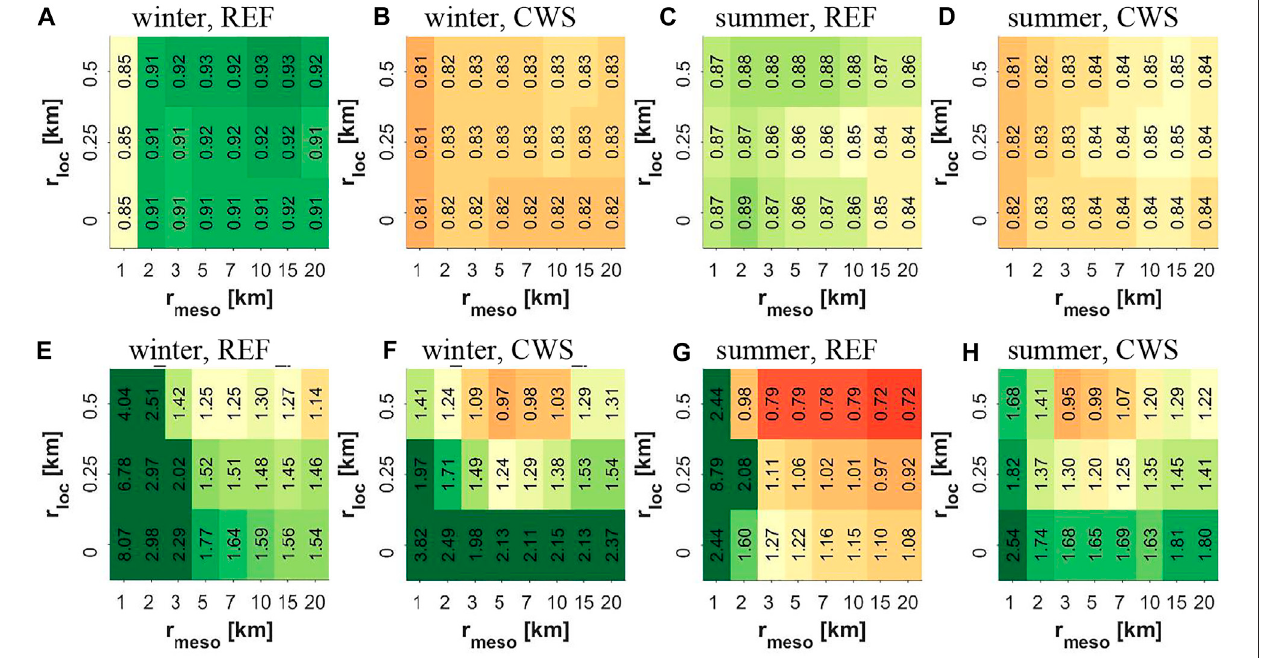
Frontiers in Environmental Science |